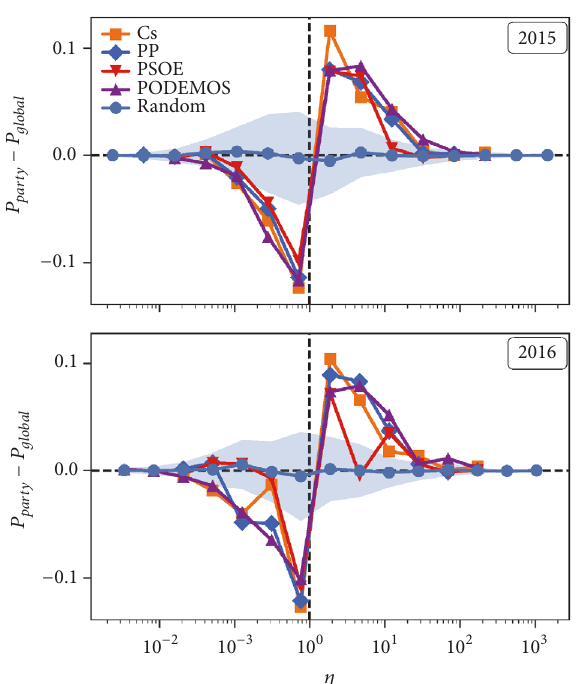
Figure 9: Probability differences of having an efficiency that falls withinagivenbin( 𝜂 𝑖 < 𝜂 < 𝜂 𝑖+1 )betweenpoliticaluserswithrespect to the total of users. The blue dots and shadowed area corresponds to the average and standard deviation of the differences for 100 samples of 1000 randomly chosen users. Political accounts tend to exhibit higher probabilities of having high efficiencies and lower probabilities of having low